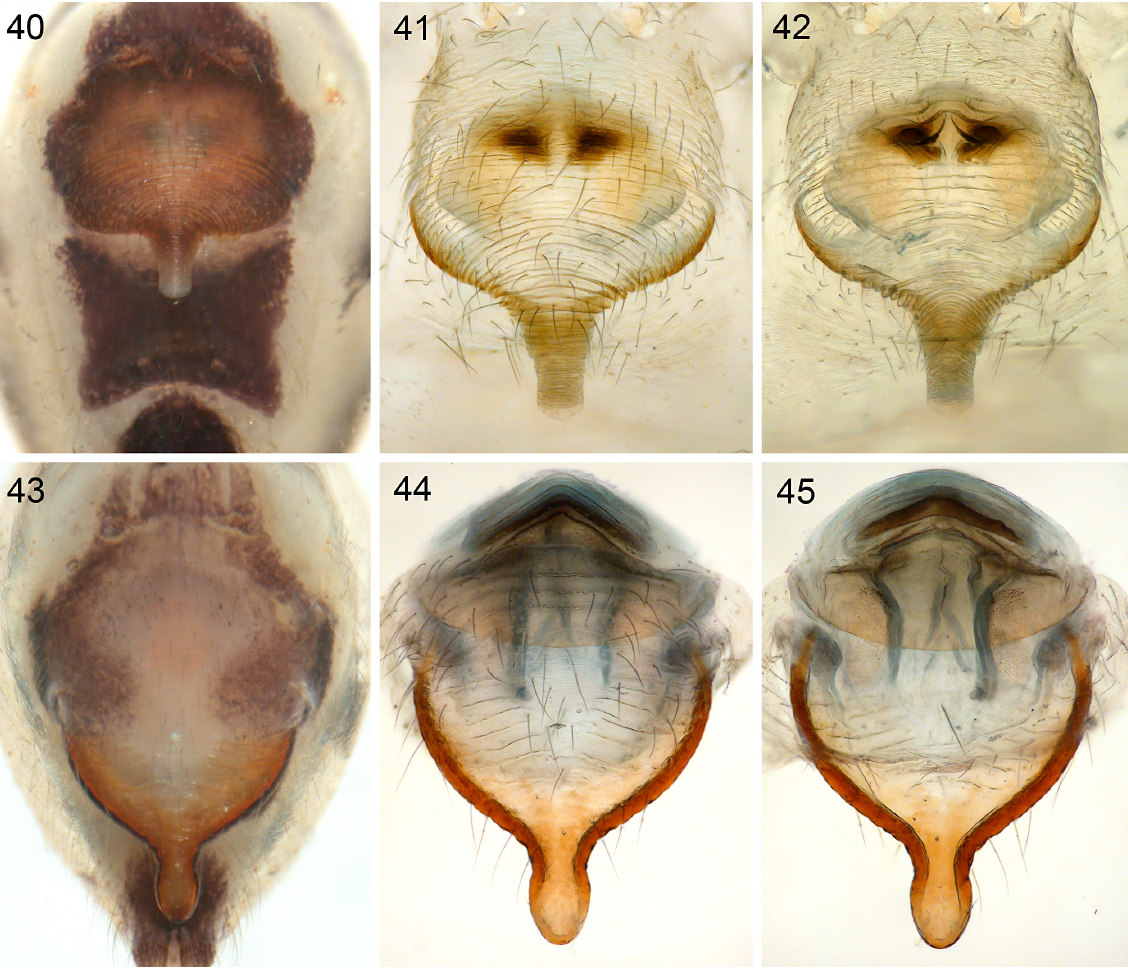
Figs 40–45. Female genitalia; untreated in ventral view, cleared in ventral and dorsal views. 40–42 . Hantu kapit gen. et sp. nov., ZFMK Ar 15070. 43–45 . Hantu niah gen. et sp. nov., ZFMK Ar 15073. At